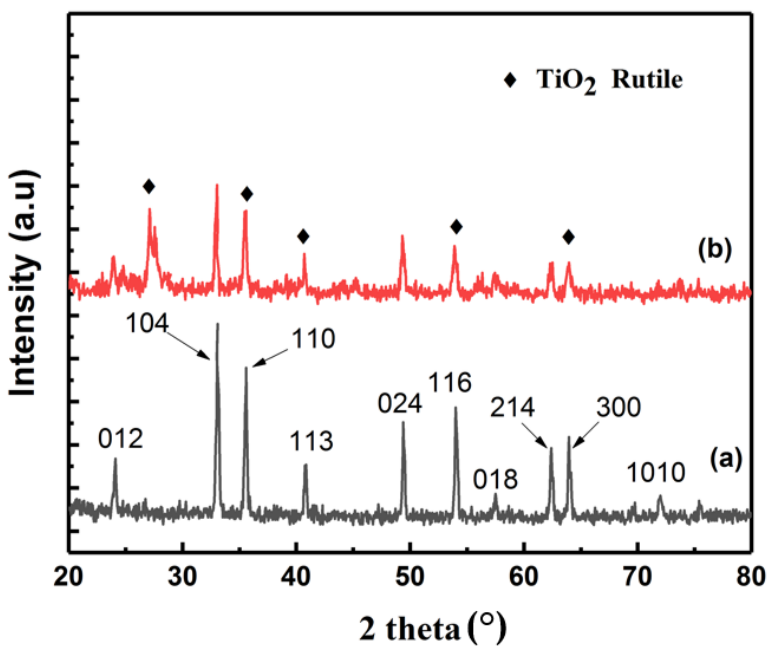
Figure 2. ( a ) XRD pattern for pristine α -Fe 2 O 3 hematite powder. ( b ) XRD pattern of green synthesized α -Fe 2 O 3 @ TiO 2 .